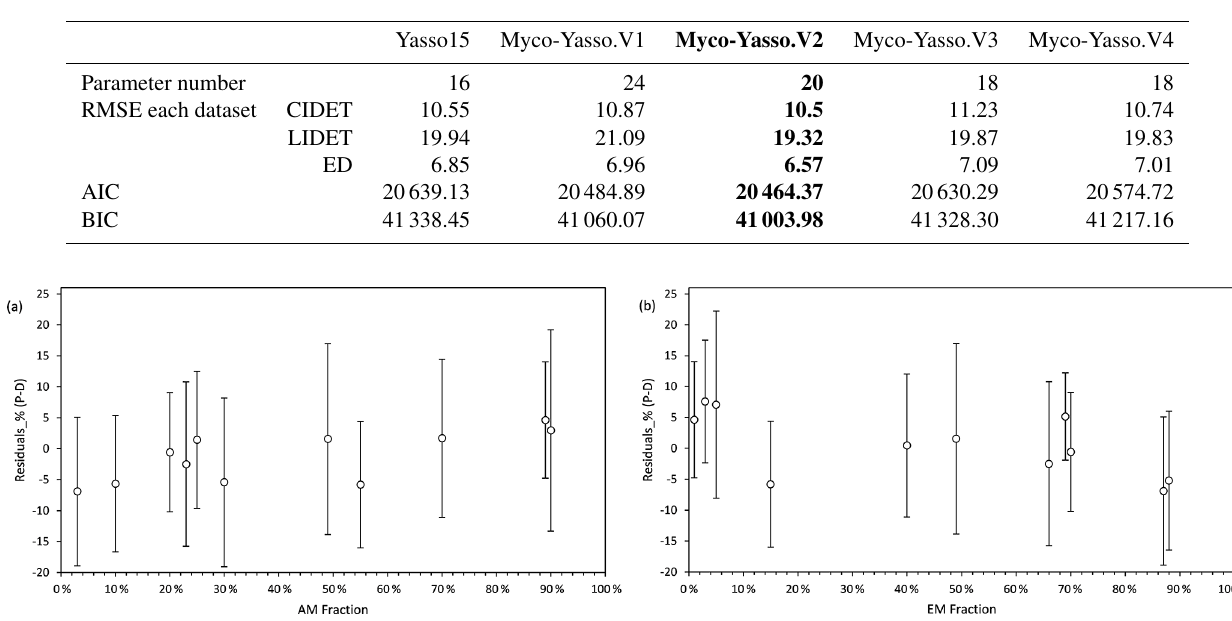
Table 2. Model performance based on RMSE for the 20% validation dataset and AIC and BIC for the 80% data used for calibration. Model predictions are based on the total mass remaining in plant litter of different mycorrhizal model versions for different litter decomposition datasets. The selected model and its performance indexes are in bold.